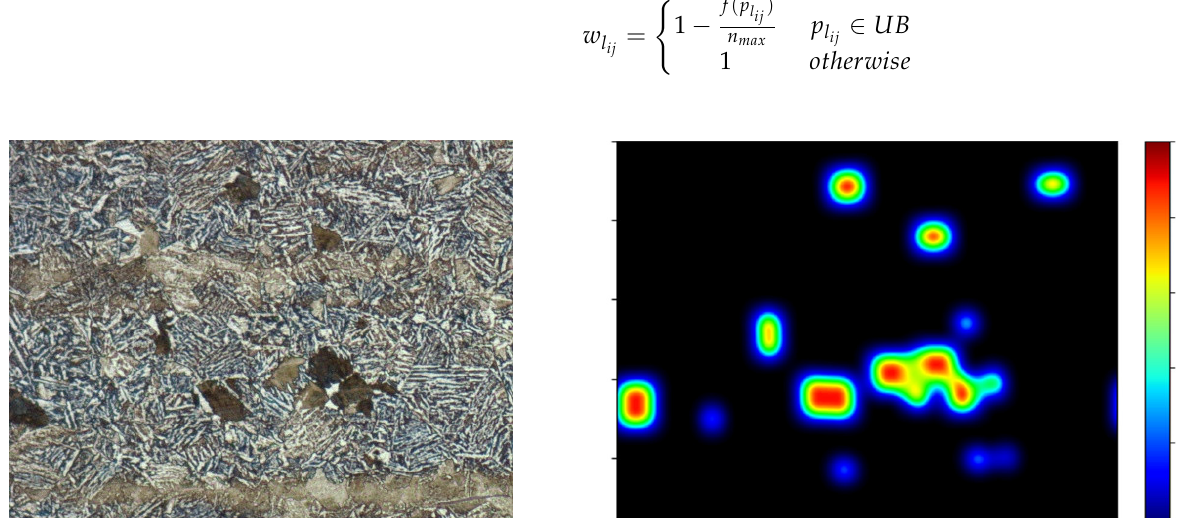
Figure 4. The visualization of the attention bias of pearlite (P) in a multi-phase